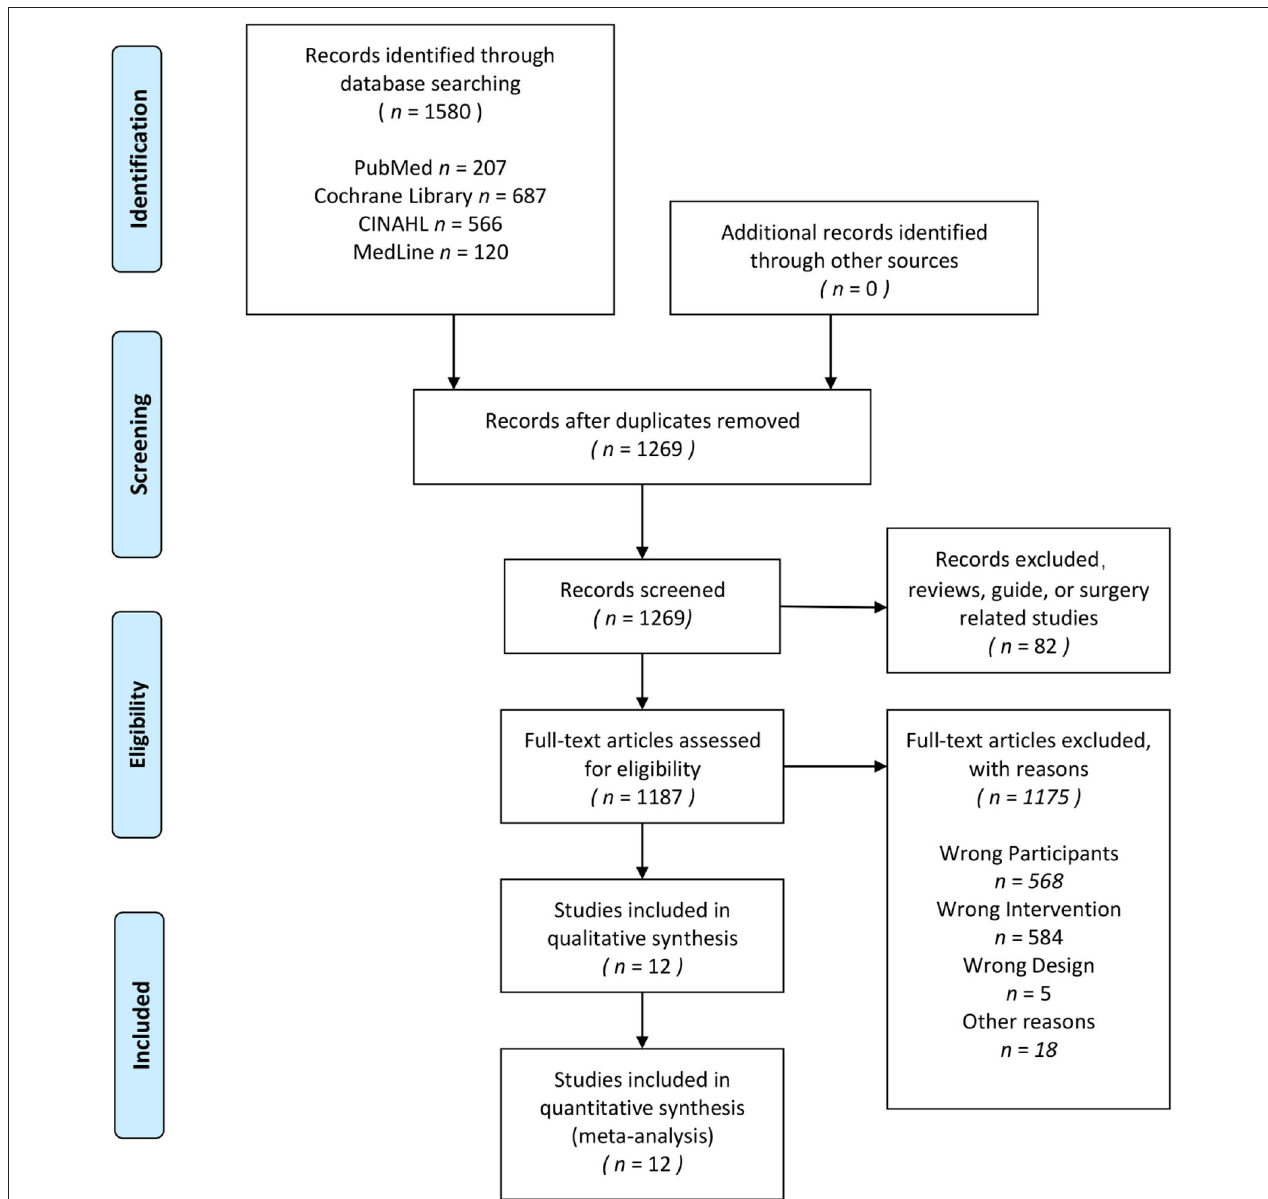
FIGURE 1 | PRISMA flow diagram for the systematic review and the network meta-analysis. Adapted from Moher et al. (52). For more information, visit